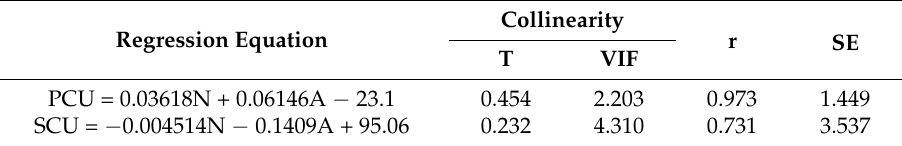
Significant at p < 0.05. Variance inflation factor (VIF).